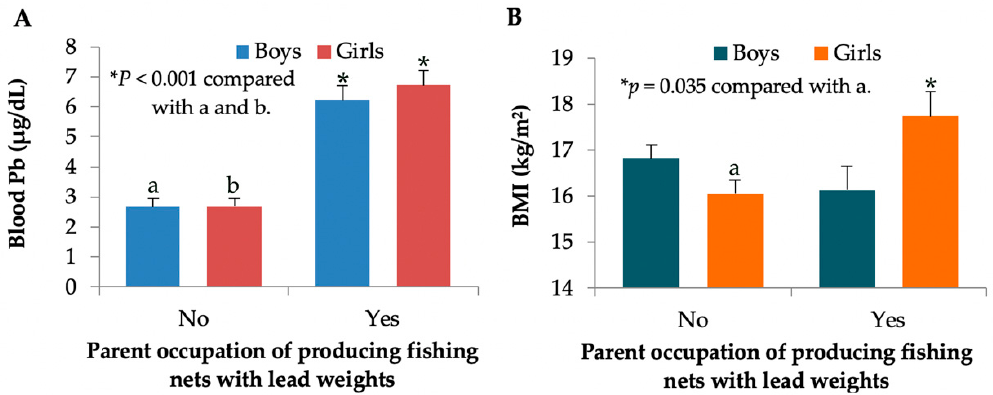
Figure 1. Blood Pb levels and BMI stratified by gender and parent occupation. Bars in ( A ) represent age-adjusted mean ± standard error of mean (SE) for blood Pb levels, while bars in ( B ) represent age-adjusted BMI ± SE in boys and girls from parents with and without an occupation of producing fishing nets with lead weights. * p values ≤ 0.05 identify statistical significance.